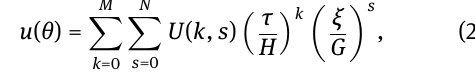
and the dashed curves represent the profiles directly ob- tained from Eq. (15). Although for small τ values, dis-